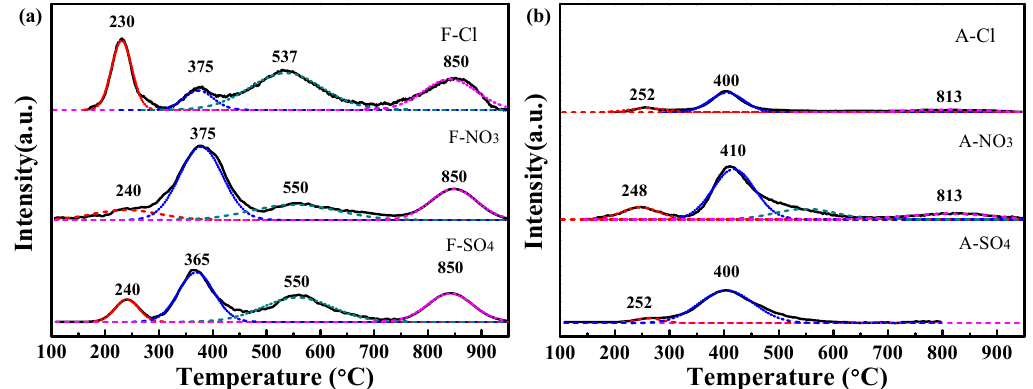
Figure 3. Hydrogen-temperature-programmed reduction (H 2 -TPR) profiles of Cu II − SSZ − 13 catalysts before ( a ) and after ( b ) hydrothermal aging treatment. Table 3. H 2 consumption of Cu II − SSZ − 13 catalysts before and after hydrothermal aging treatment.